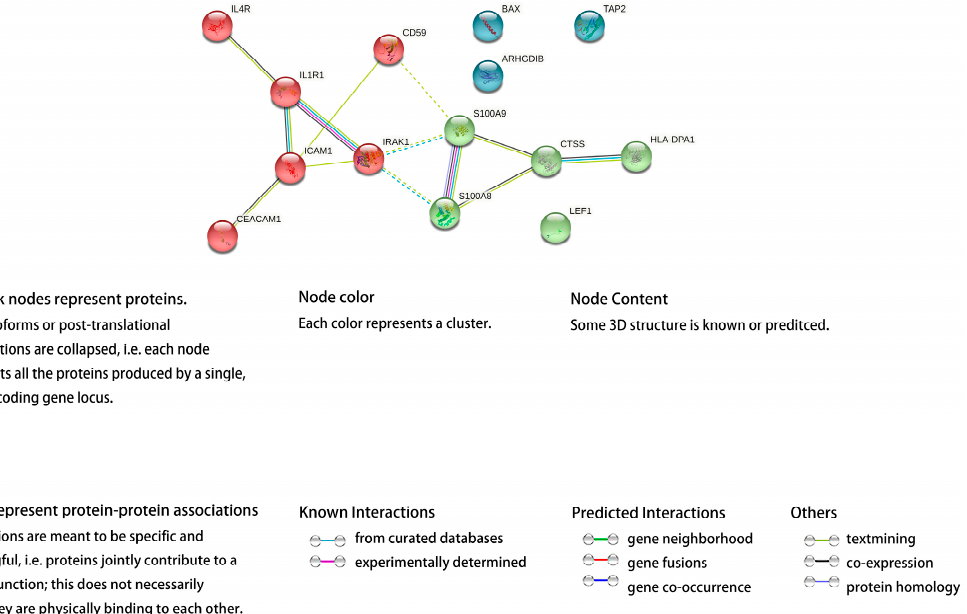
Figure 6. PPI network of the common 14 up-regulated differentially expressed genes (DEGs) in both pterygium and primary Sjögren Syndrome (pSS) samples.